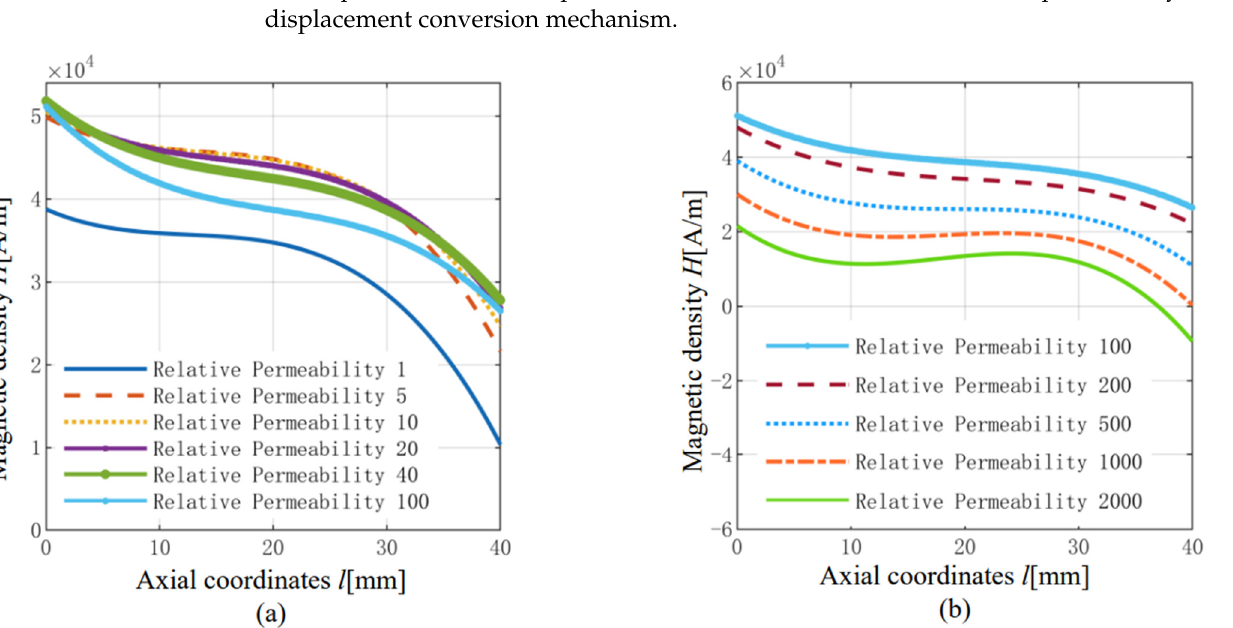
Figure 10. The axial magnetic density distribution of the GMM cylinder by changing the relative permeability of the displacement conversion mechanism. ( a ) u r =1, 5, 10, 20, 40, 100, ( b ) u r =100, 200, 500, 1000, 2000.